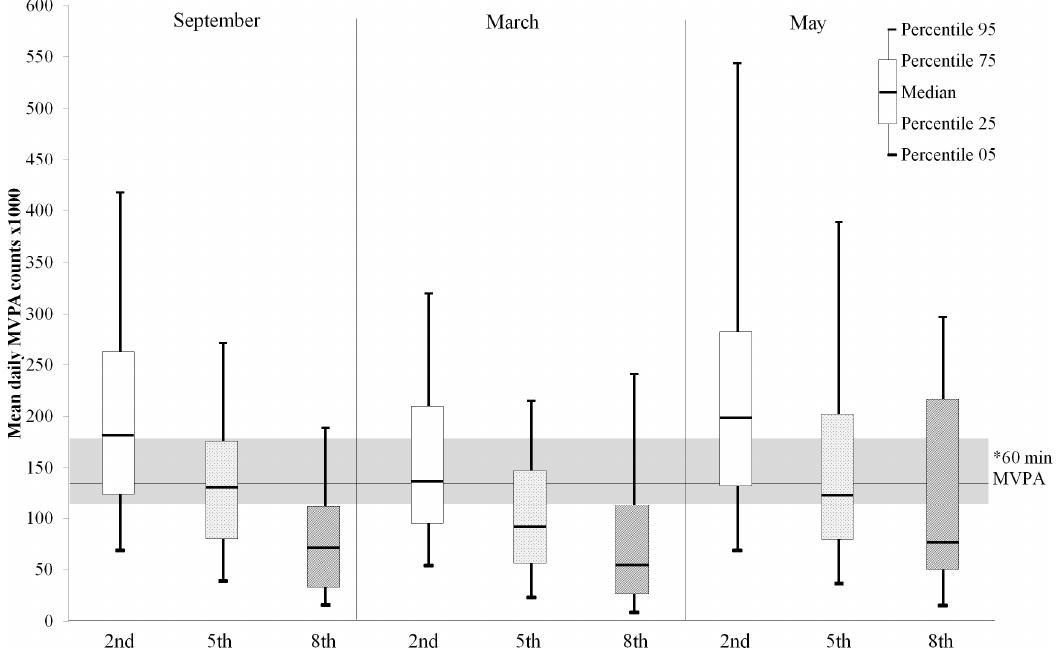
Figure 3. Swedish pupils’ mean daily MVPA counts (×1000) by season and grade; * Children who reached the recommended daily level of 60 min of MVPA during two days or more each season: In September 43 (67.2%) second graders, 39 (43.8%) fifth graders, 1 (3.8%) eighth graders, in March 35 (54.7%) second graders, 19 (21.3%) fifth graders, 8 (30.8%) eighth graders, in May 50 (78.1%) second graders, 41 (46.1%) fifth graders and none of the eighth graders.